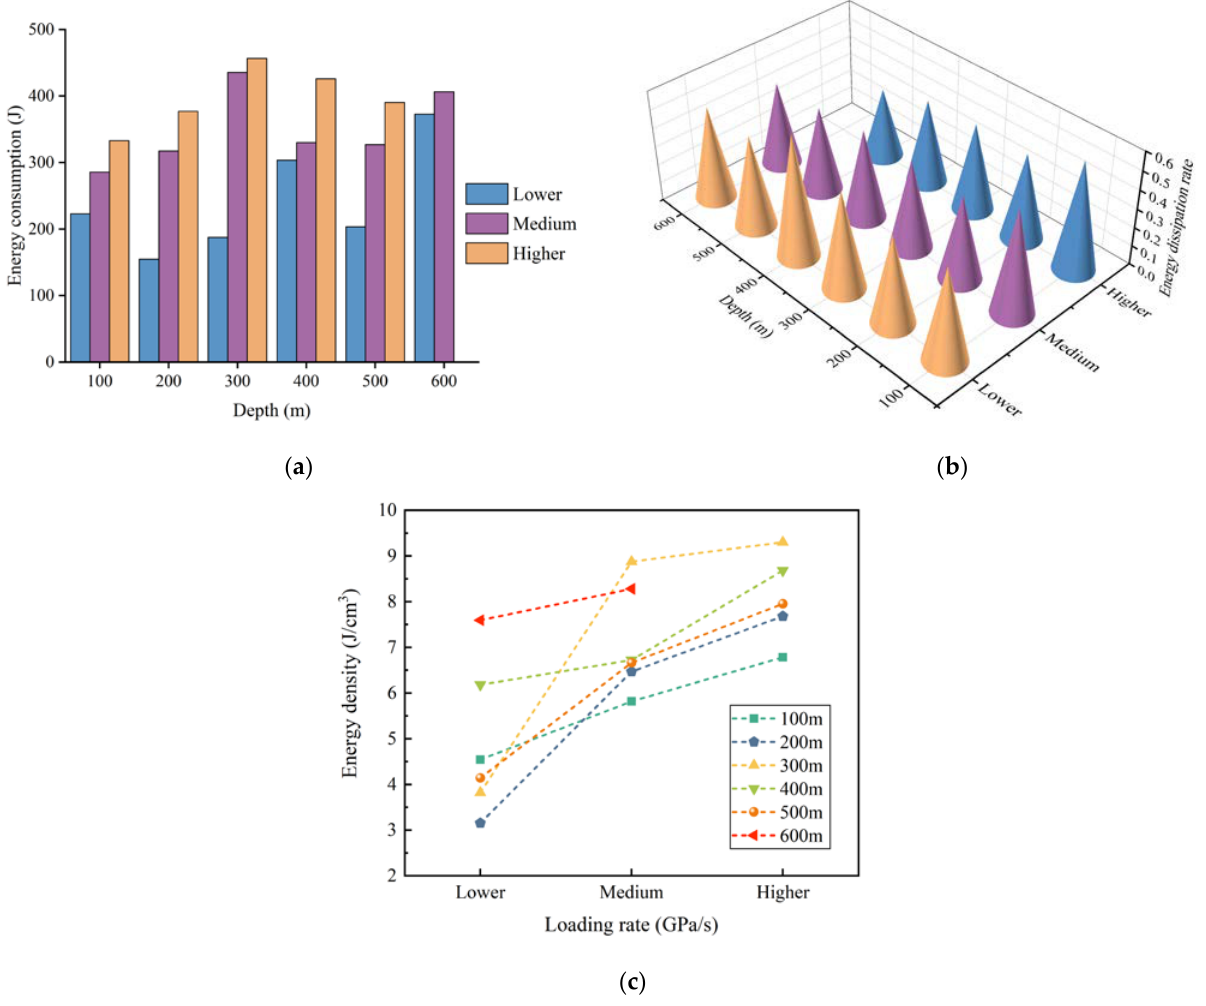
Figure 11. Energy dissipation of coal specimens in the test: ( a ) Energy consumption of coal specimen. ( b ) Energy dissipation rate of the coal specimen. ( c ) Energy density.